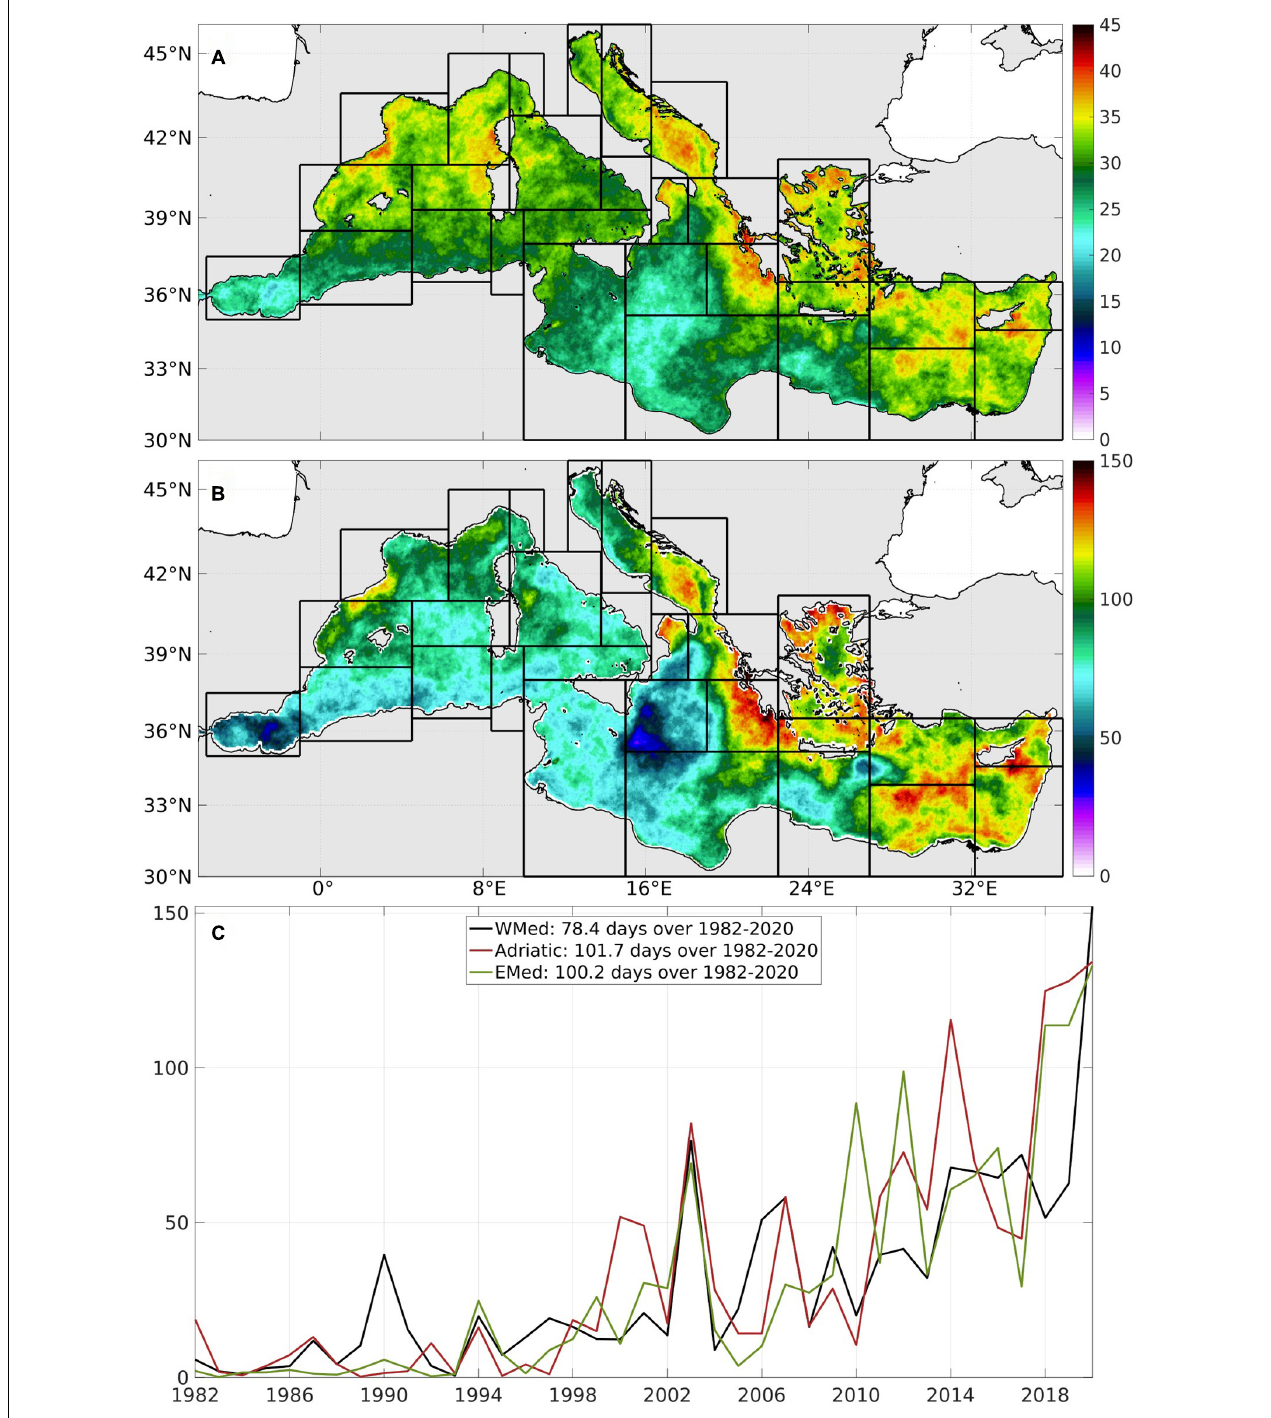
FIGURE 6 | Annual MHW total days: mean (A) and linear trend with 95% confidence level (B) over the period 1982–2020, as well as sub-basin integrated time series from 1982 to 2020 in the WMed, Adriatic Sea and EMed with associated trend values over the period (C) .